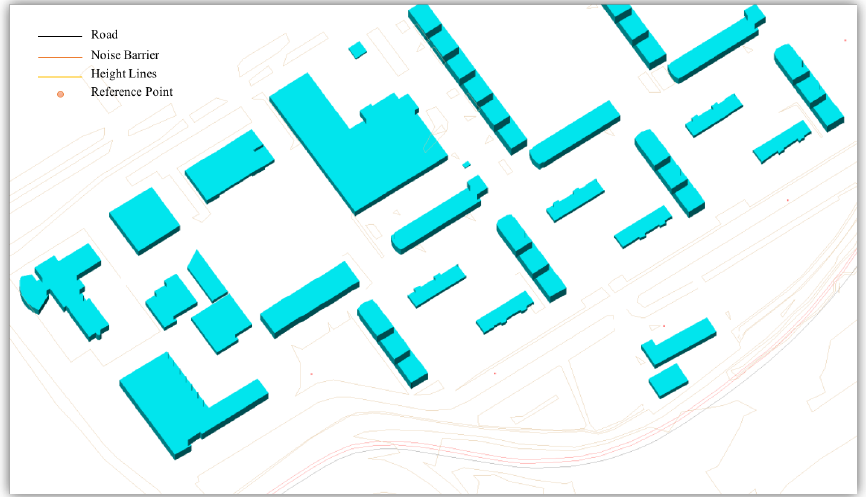
Figure 10. Three-dimensional city model of the study area in our CityGML eNoise ADE depicting buildings, roads, noise barriers, and height lines. Roads and noise barriers are modeled as 3D lines; Buildings are modeled as 3D solids; Terrain is modeled as 3D height